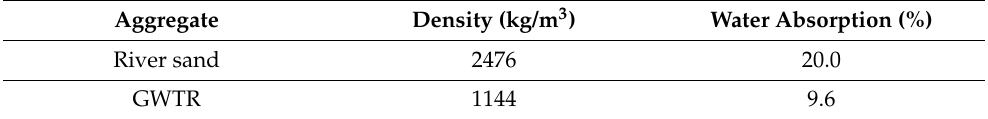
Table 2. Physical properties of river sand and GWTR.